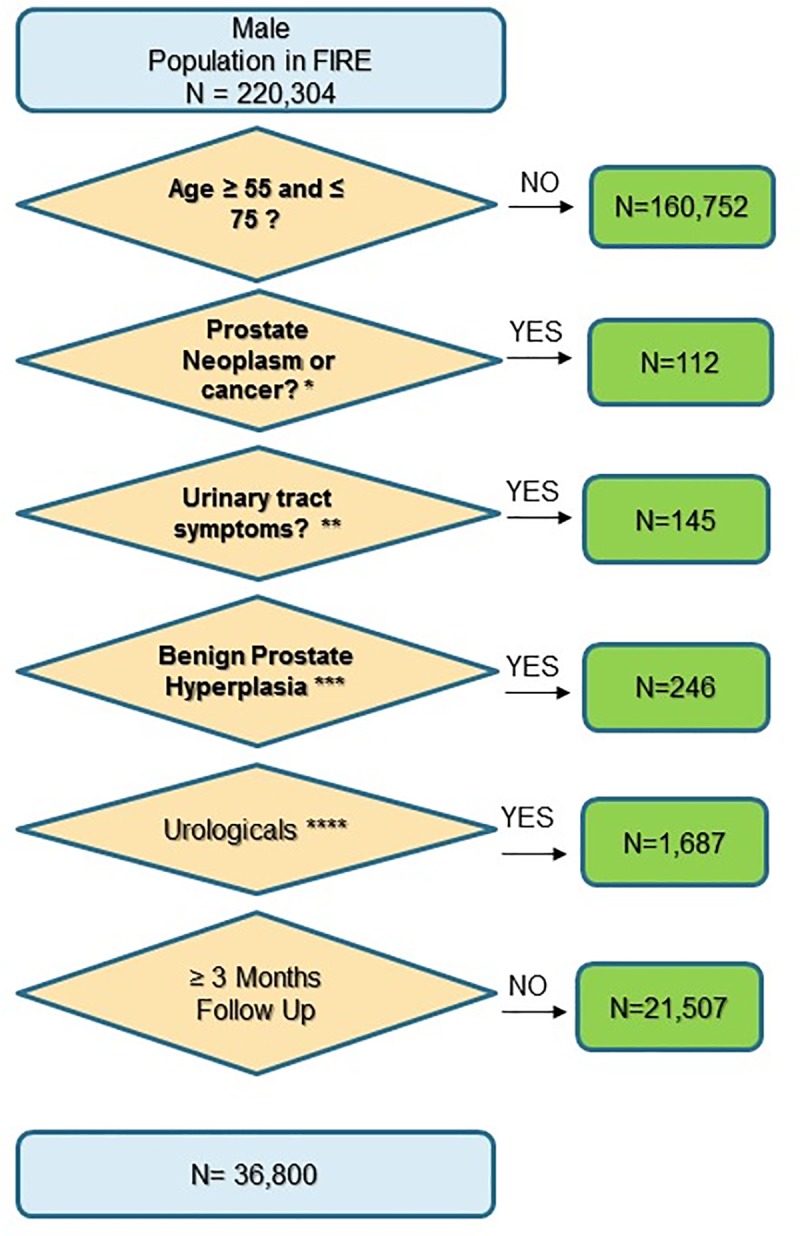
Flow chart.Fig 1 shows the inclusion and exclusion criteria: *prostate neoplasm/cancer based on ICPC-2 codes: [Y77-Y79], ** urinary tract symptoms based on ICPC-2 codes: [U01-U08], *** benign prostate hyperplasia based on ICPC-2 code [Y85], **** urologic medications based on ATC code [G04].